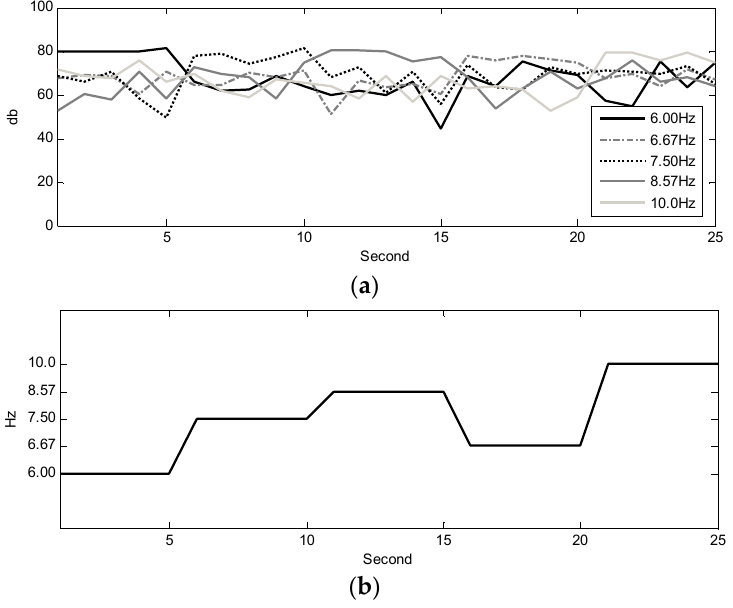
Figure 11. Steady-state visual evoked potential (SSVEP) EEG signal is converted to a control signal. ( a ) The power energy of a subject's EEG response for different stimulus frequency. ( b ) Decision results.